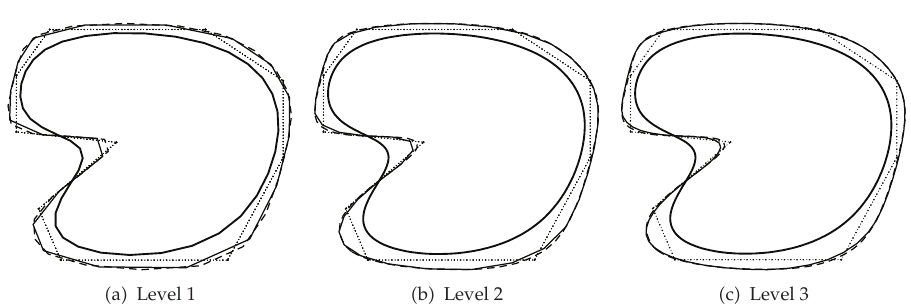
Figure 4: It shows the comparison at 1st, 2nd, and 3rd level of binary, ternary, and quaternary 4-point approximating schemes. Dotted lines indicate initial control polygons, whereas dashed, thin solid, and bold solid continuous curves are generated by binary, ternary, and quaternary schemes, respectively.